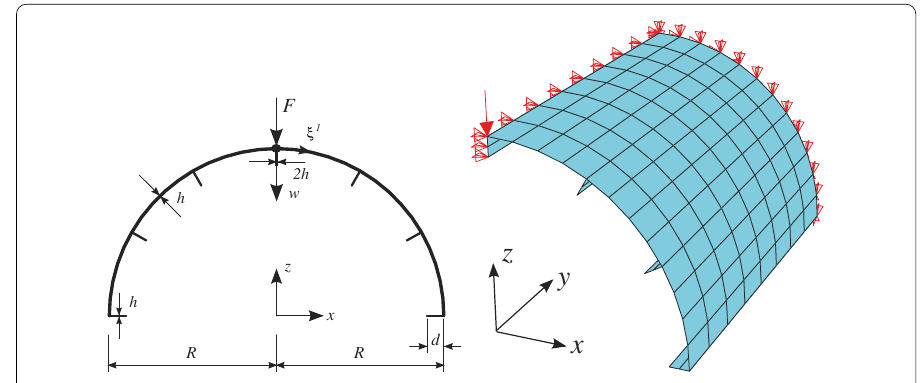
Fig. 37 Stiffened cylindrical shell and regular finite element mesh (12 × 8 × 2)